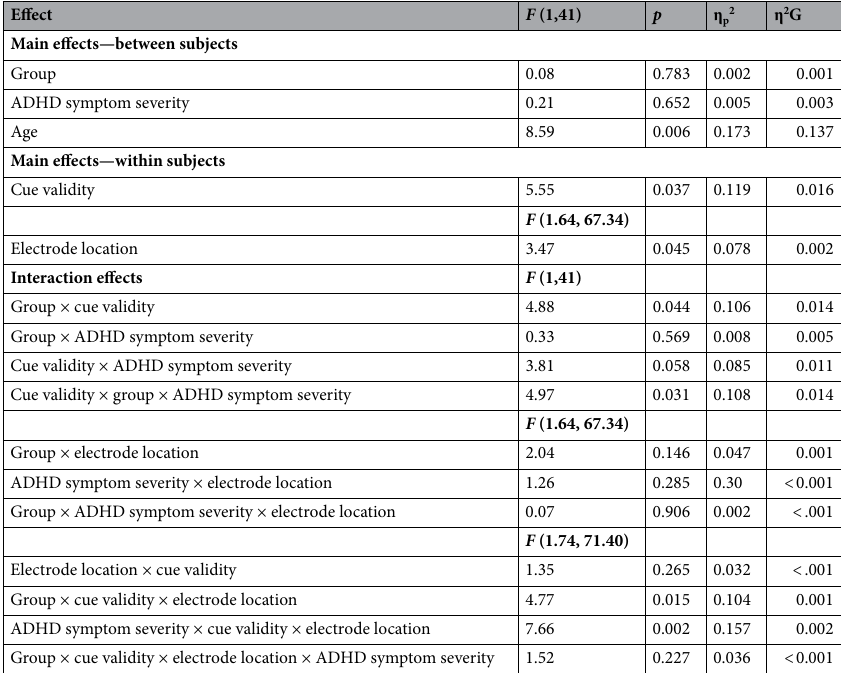
Table 7. Cue validity effect and group differences in the cue validity effect on N1a amplitude. ADHD: Attention-Deficit/Hyperactivity Disorder.